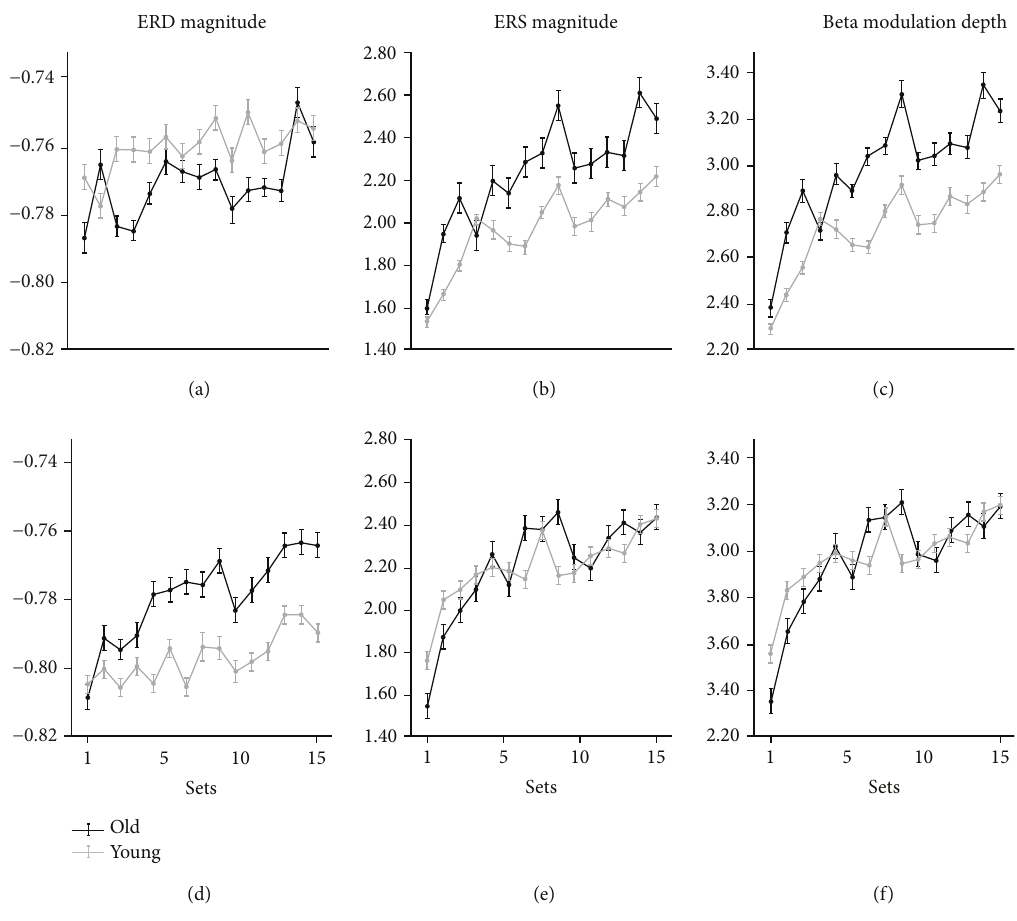
Figure 3: Average of ERD (a, d), ERS (b, e), and beta modulation (c, f) magnitudes for the left (upper row) and frontal (lower row) ROIs for each set in the younger (grey lines and dots) and older (black lines and dots) groups. The vertical bars represent the standard errors of the